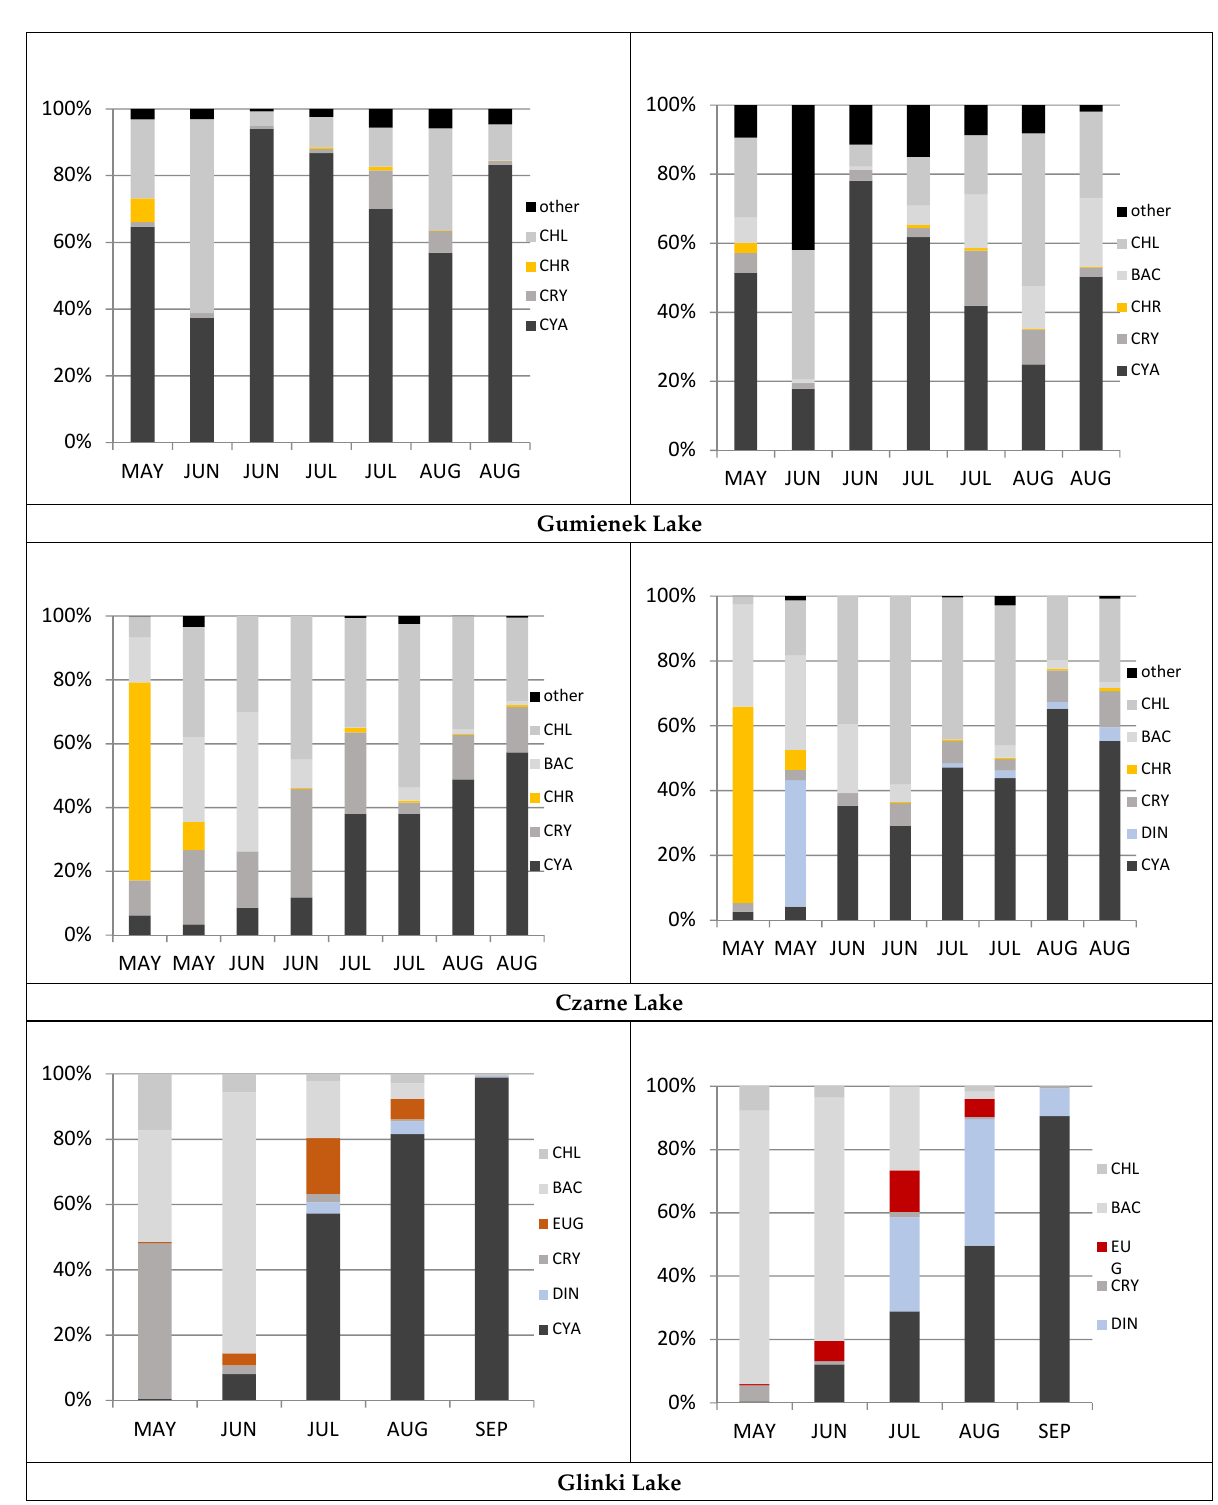
Figure 1. Percentage shares of numbers (left column) and wet biomass (right column) of phytoplankton in the studied lakes in the following month of study. Abbreviations: